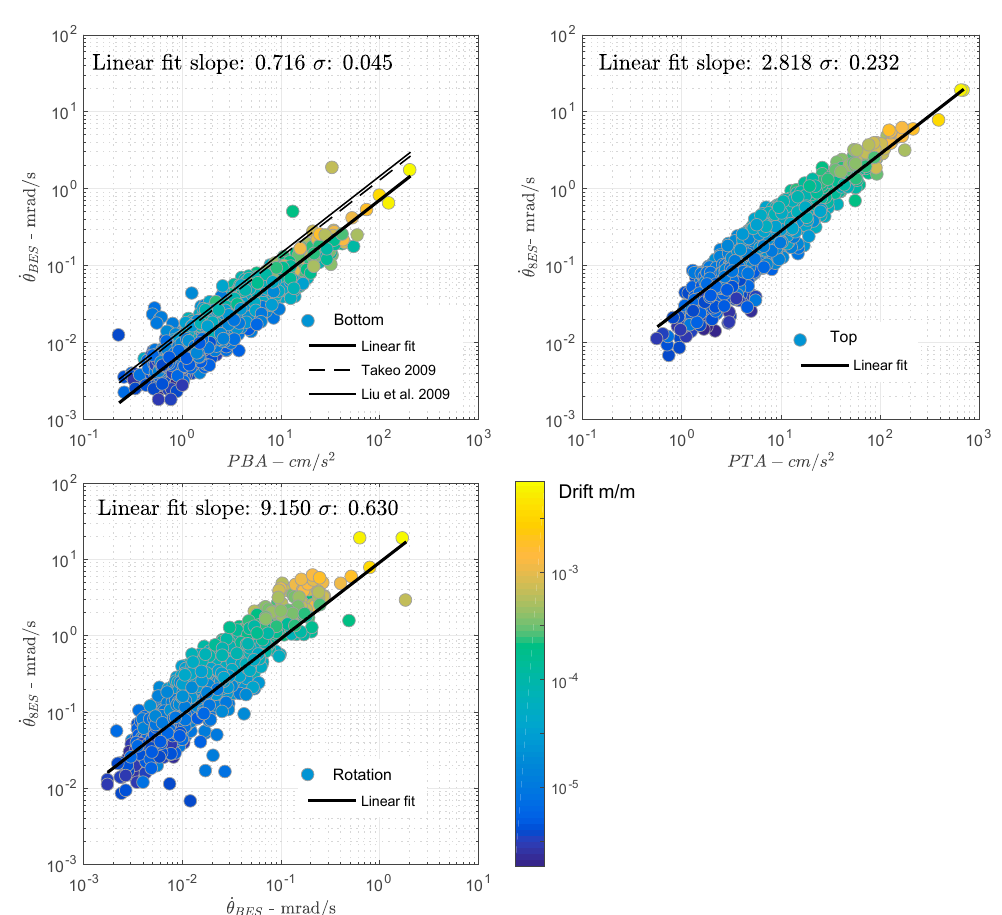
Figure 7. Comparison of the translational (cm/s 2 ) and rotational rates (mrad/s) observed in the ANX building: ( a ) at the bottom, ( b ) at the top, ( c ) comparison of bottom and top rotational rates. Thick lines correspond to a linear function (y = ax + b) fitted to the data. σ is the standard deviation of the residual values (observed–predicted).